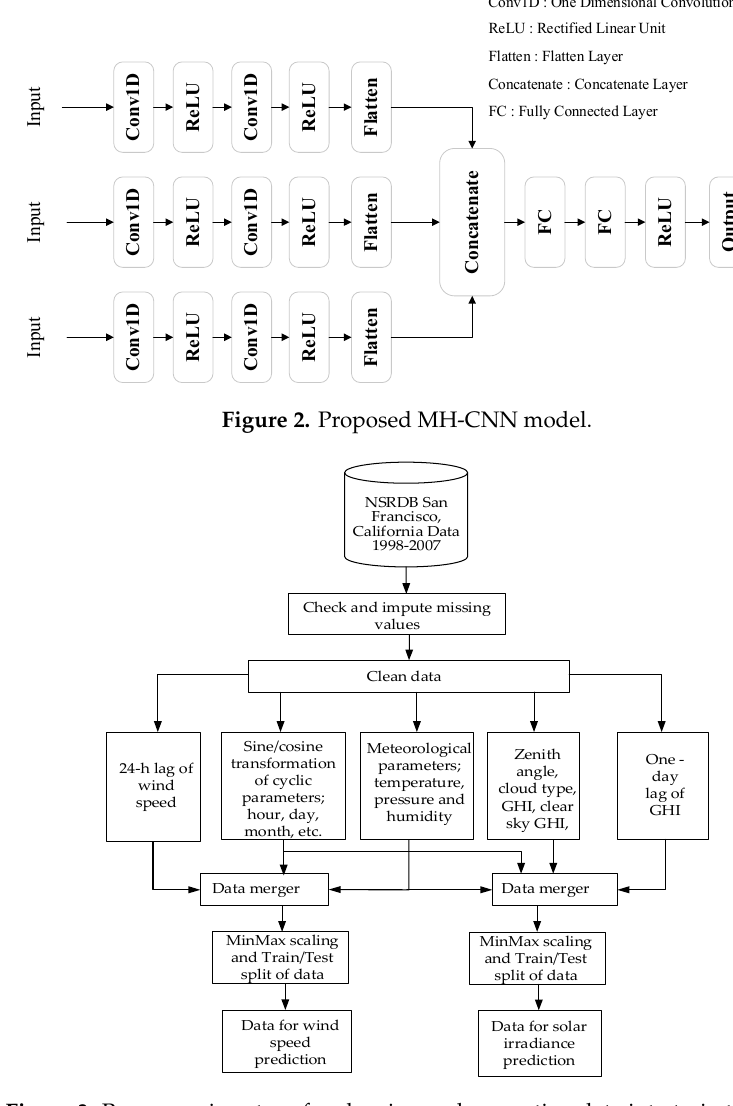
Figure 3. Preprocessing steps for cleaning and separating data into train test sets.